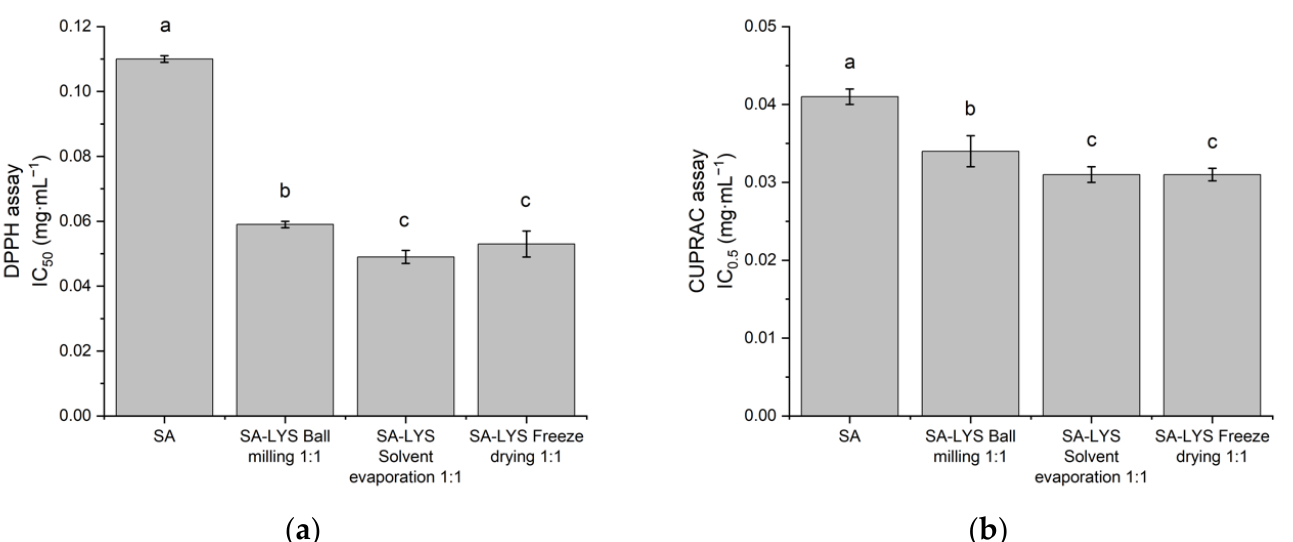
Figure 4. Antioxidant activity of SA and SA co-amorphous systems with LYS in molar ratio 1:1 evaluated using the DPPH ( a ) and CUPRAC ( b ) models. Mean values with the same letter are not significantly different at p < 0.05 using Duncan’s multiple range test. “a” stands for the highest values, “b” and “c” stand for the statistically significant decreasing values.